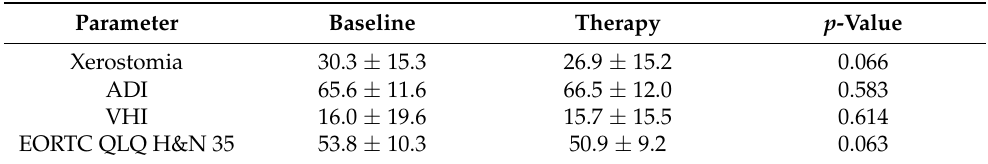
Table 2. Xerostomia, dysphagia, dysphonia and quality of life at baseline and after therapy (ADI = Anderson Dysphagia Inventory, VHI = Voice Handicap Index, EORTC QLQ H&N = European Organization for Research and Treatment of Cancer quality of life questionnaire head and neck).